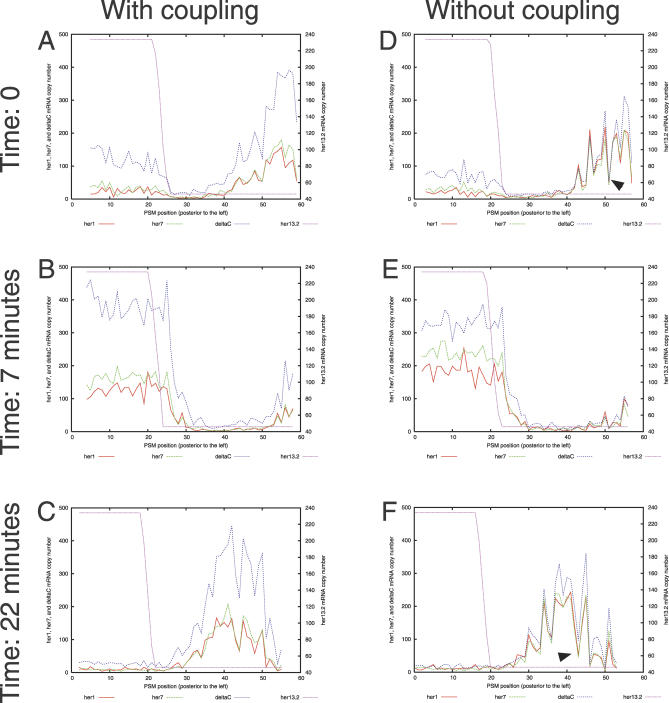
Stochastic Simulations of a Chain of Oscillators Corresponding to the Model Sketched in Figure 1, with Normal Coupling through Delta-Notch Signaling (A–C) and with Disrupted Coupling (D–F)When coupling was absent, some cells were noticeably out of synchrony with their neighbors (arrowheads), and local synchrony was not as strong. The transcription rate of her1 and her7 was increased in (D–F) to make up for the loss of Notch signaling.